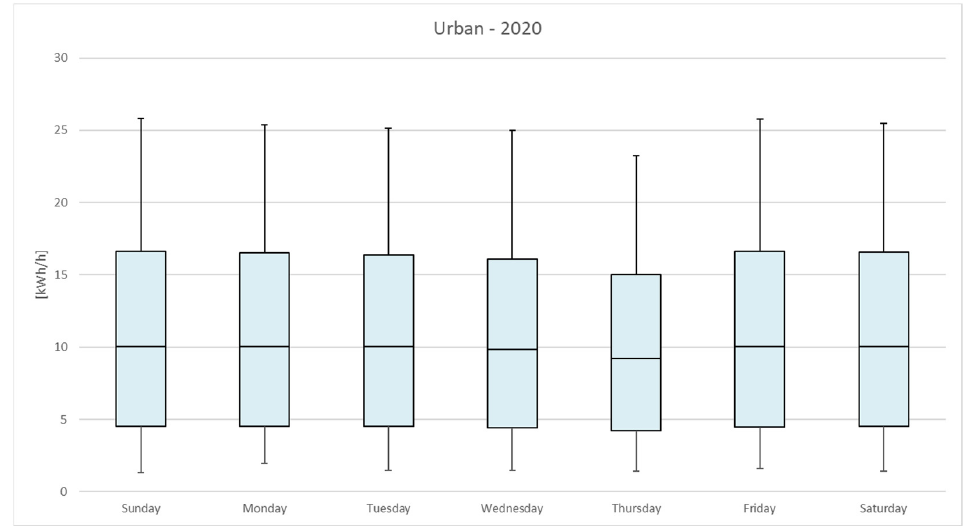
Figure 3. Box and whiskers plots for days of the week in 2020 (urban).